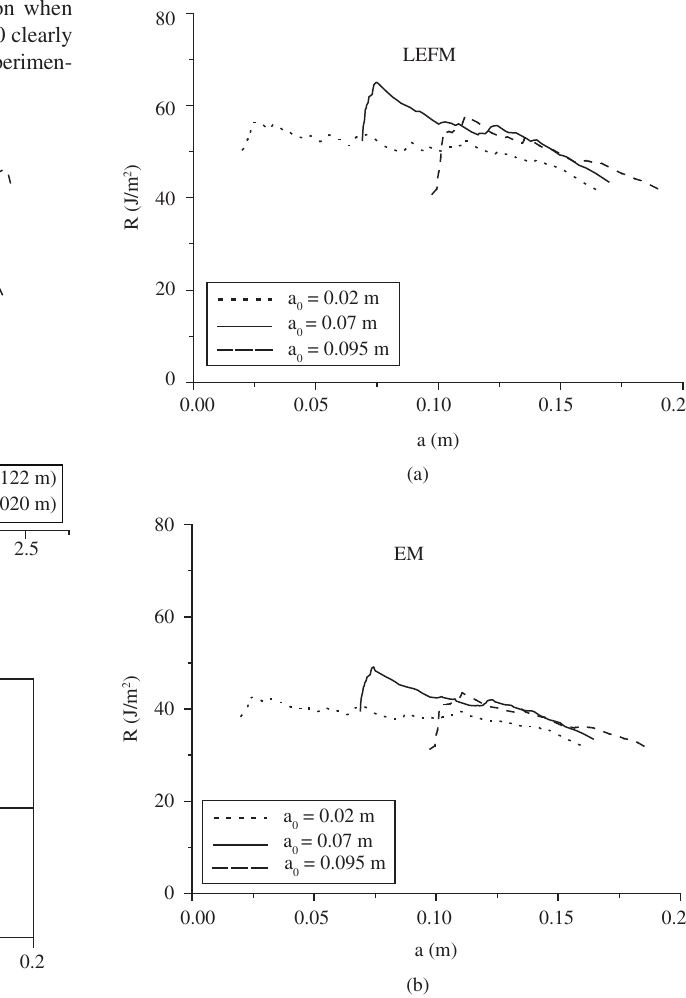
= 0.02 m, 0.07 m 0